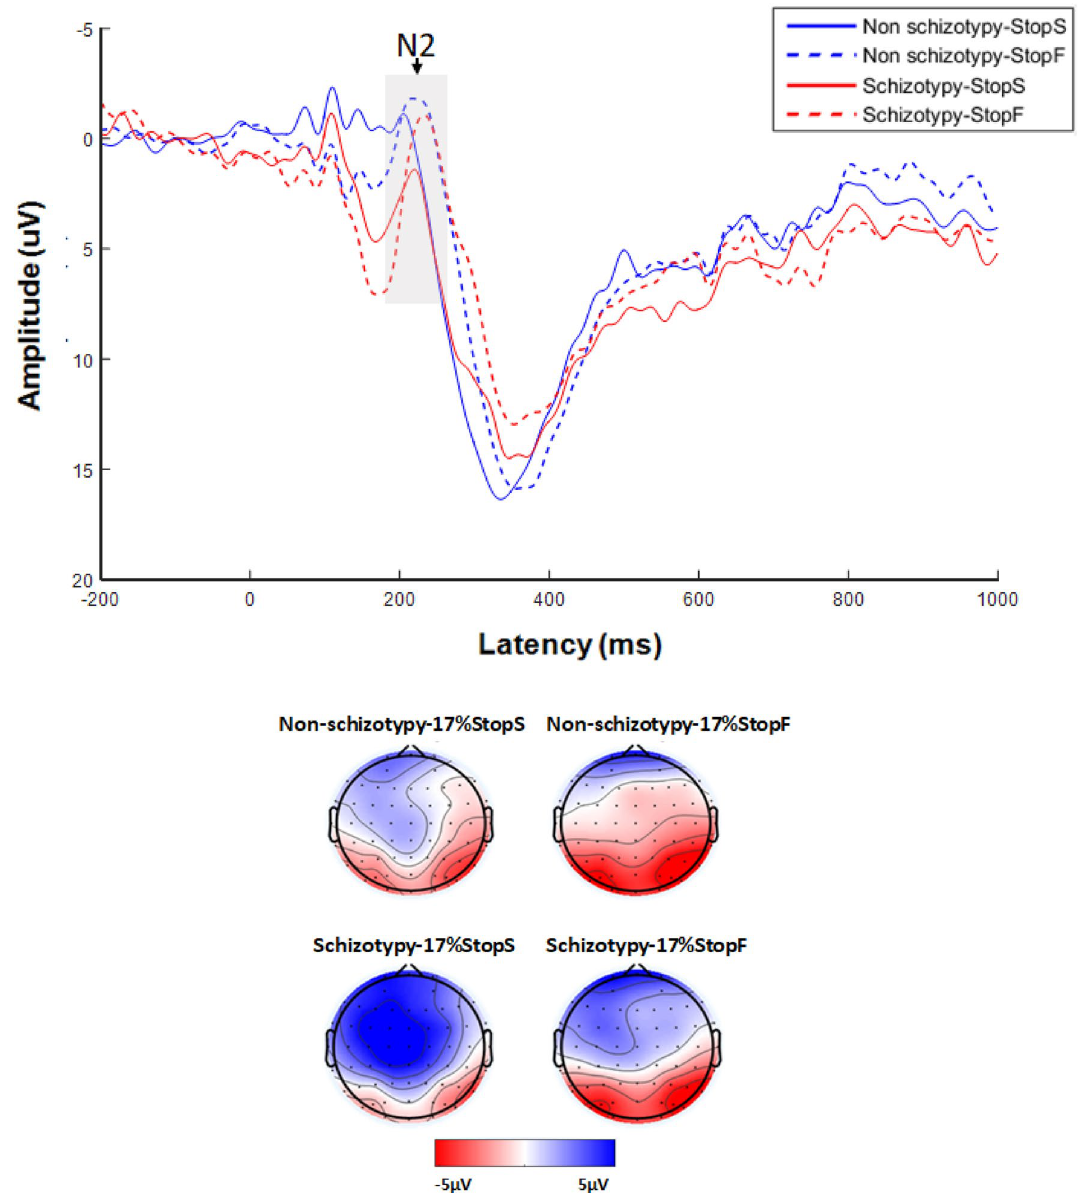
Figure 5. Grand-average event-related potentials (ERPs) elicited by “17% stop” trials associated with successful stop (StopS) and failed stop (StopF) at the Fz, F1, and F2 recording site for the non-schizotypy and schizotypy group. The gray-shaded areas indicate the 175- to 250-ms time window for the calculation of the mean value of the N2 wave. The time point “0” indicates stimuli